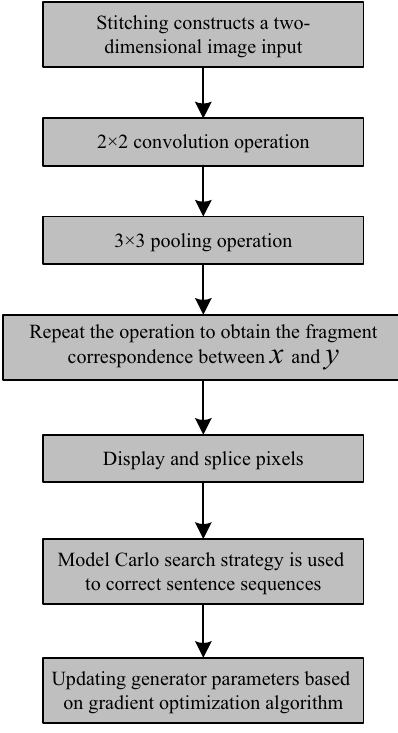
Figure 5: Optimized algorithm fl ow chart.